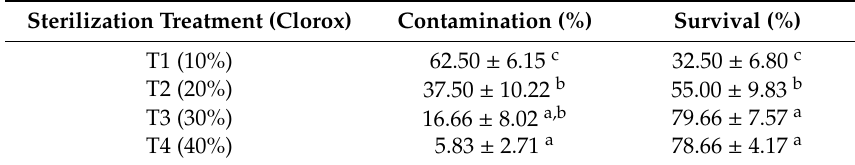
Table 1. Mean contamination level (%) and mean survival rate (%) of A. longiloba seeds one month after exposure to different sterilization treatments.